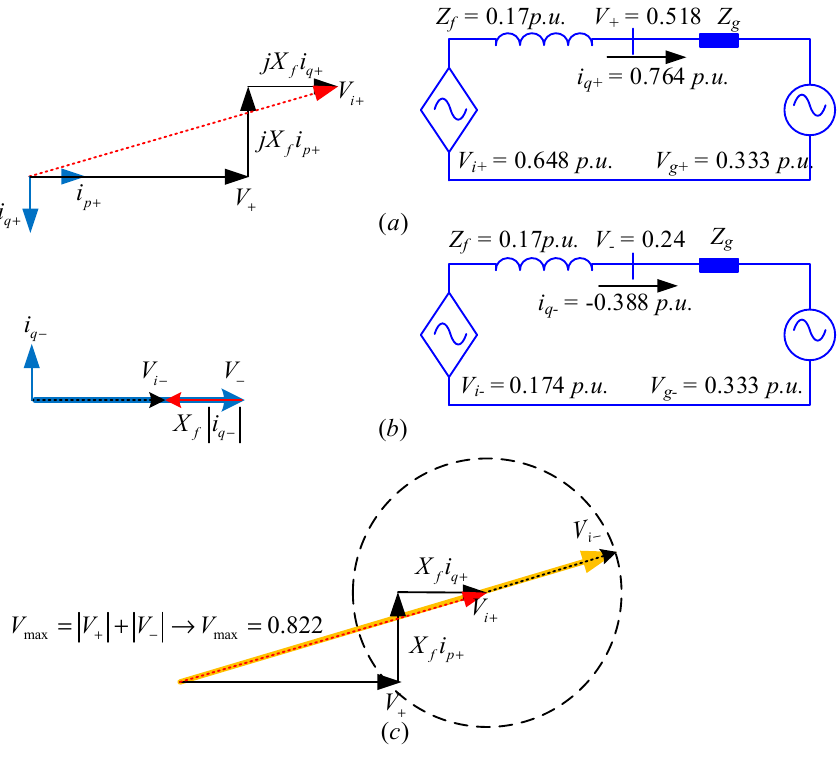
Figure 5. Vector representation of voltages and currents GC-VSC when there is an unbalanced voltage sag. ( a ) Positive sequence. ( b ) Negative sequence. ( c ) Inverter voltage in the worst case.